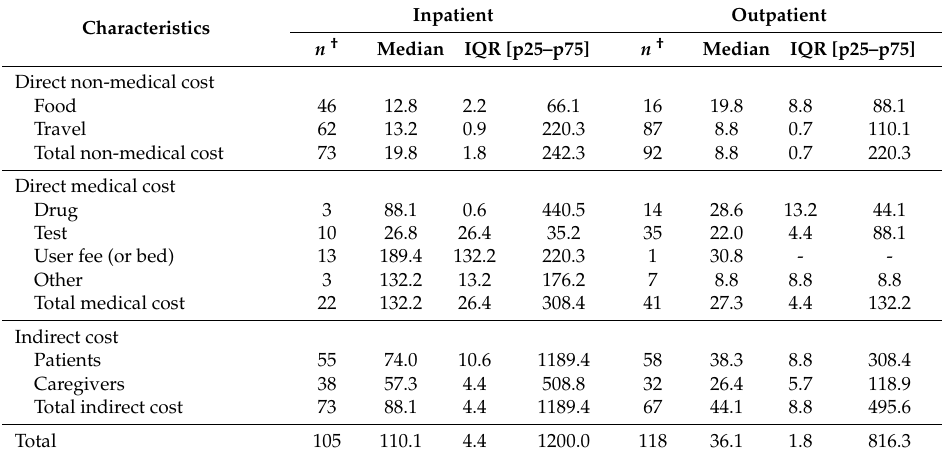
Table 3. Cost of treatment among patients with dengue fever (Unit: